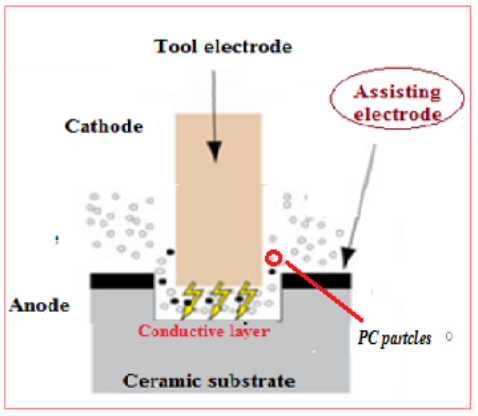
Figure 3: Schematic diagram of micro-EDM of nonconductive ceramics with fixed AE